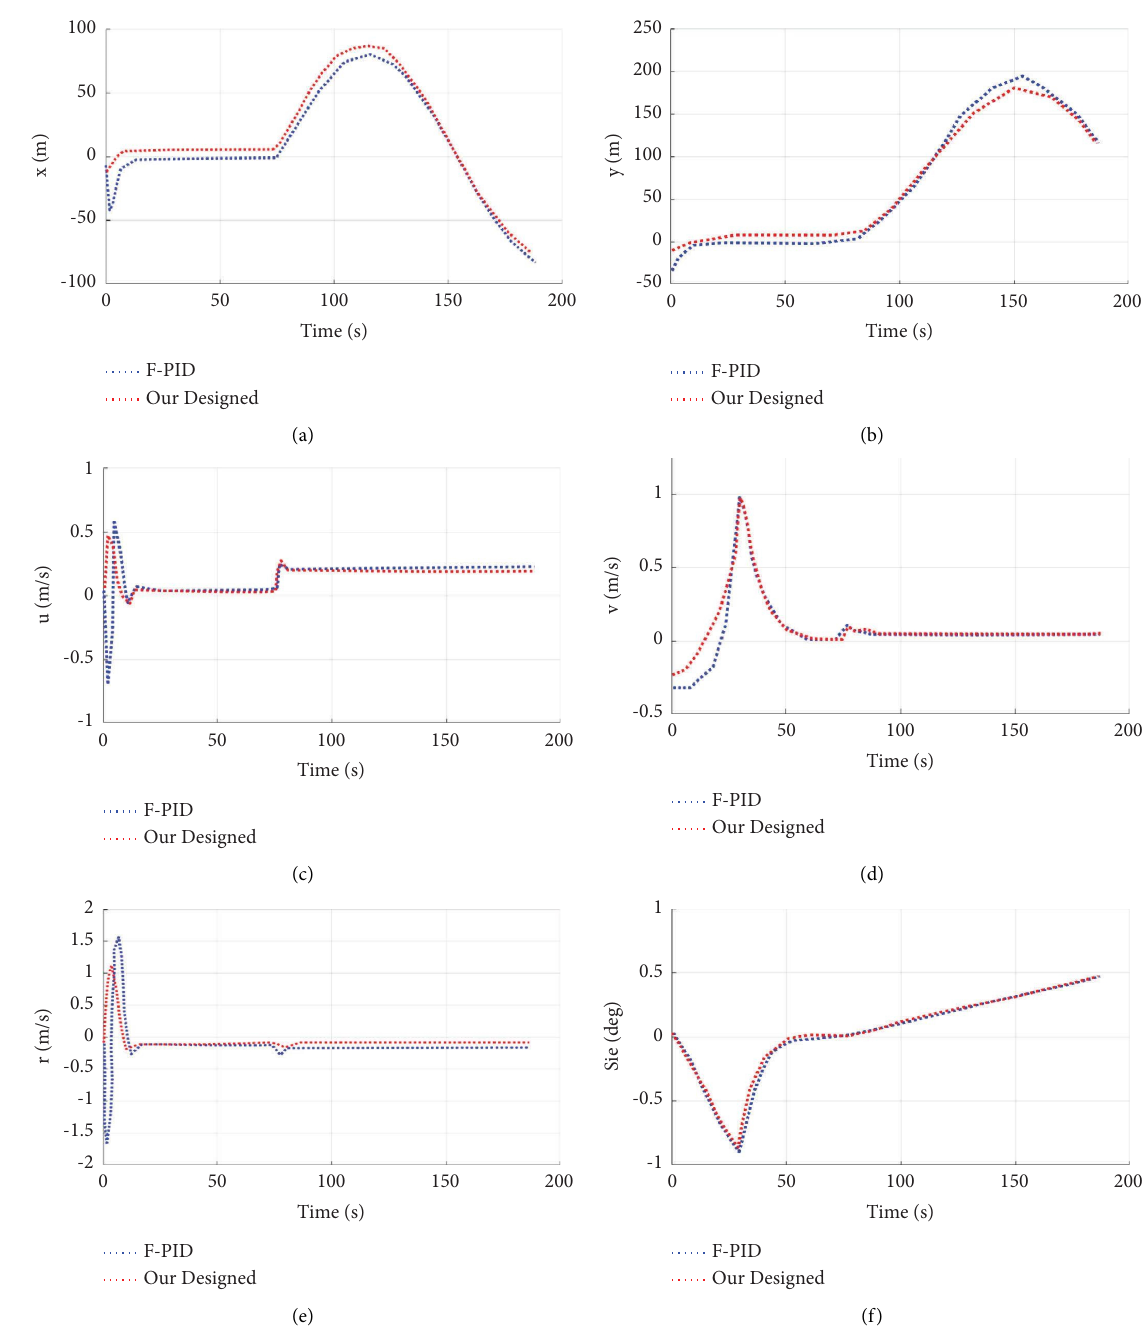
Figure 7: (a–f) state curves of USV with respect to